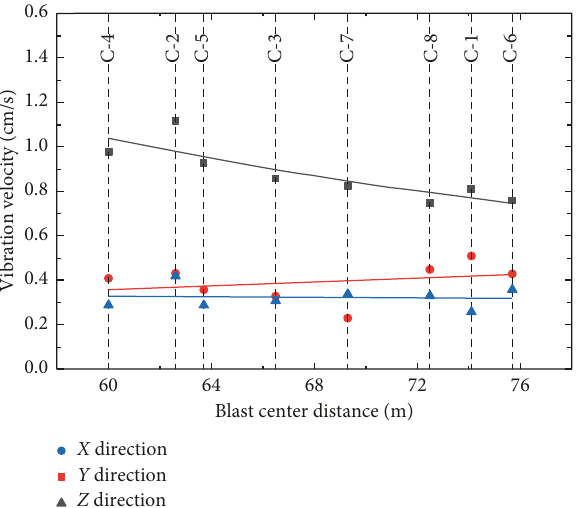
Figure 13: Relationship between the vibration velocity and the blast center distance of the upper step.